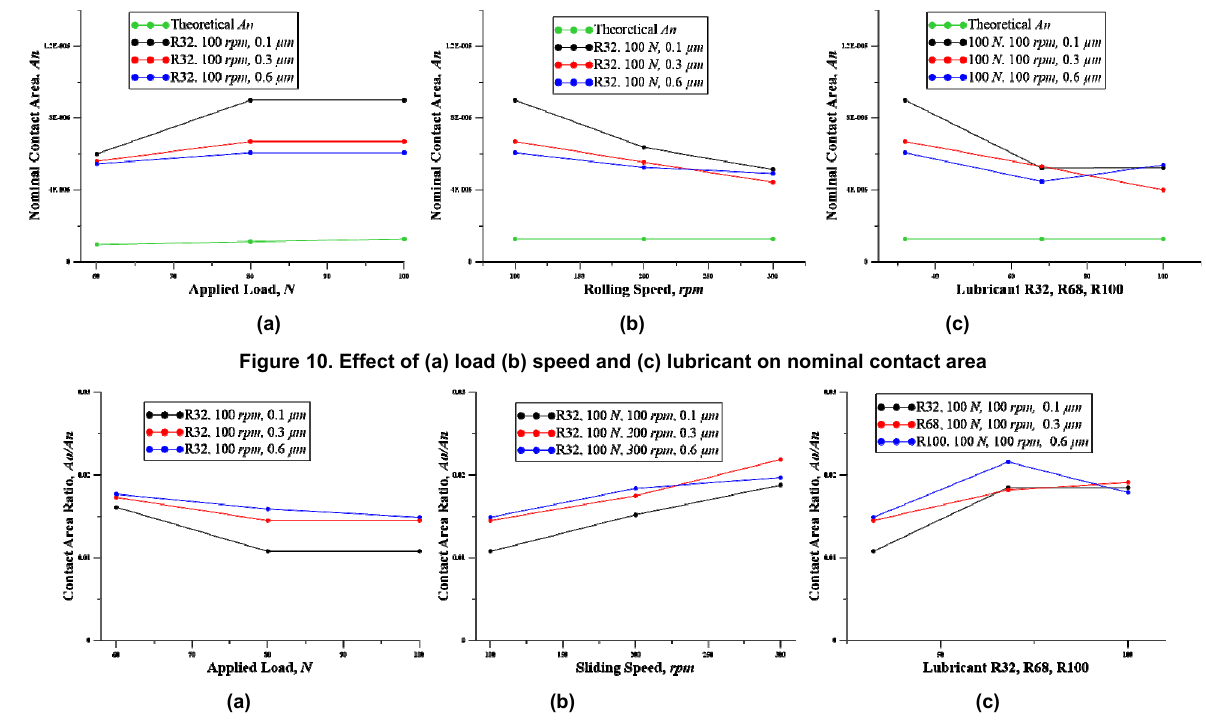
Figure 11. Effect of different (a) load (b) speed and (c) lubricant on contact area ratio